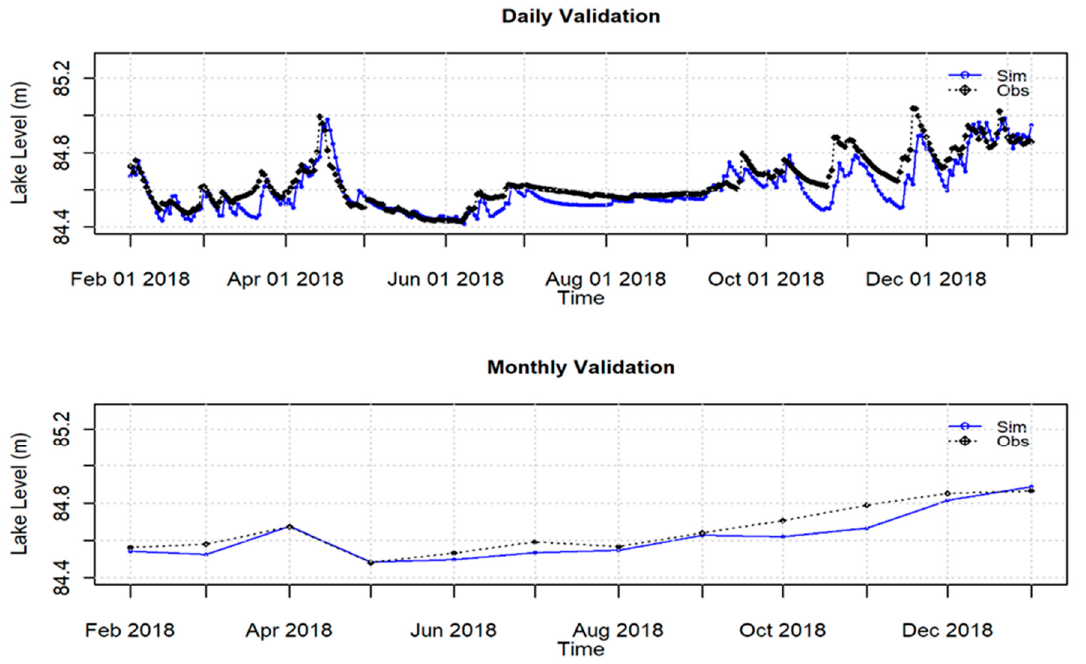
Figure 8. Daily and monthly simulated and observed lake level change for the validation period.